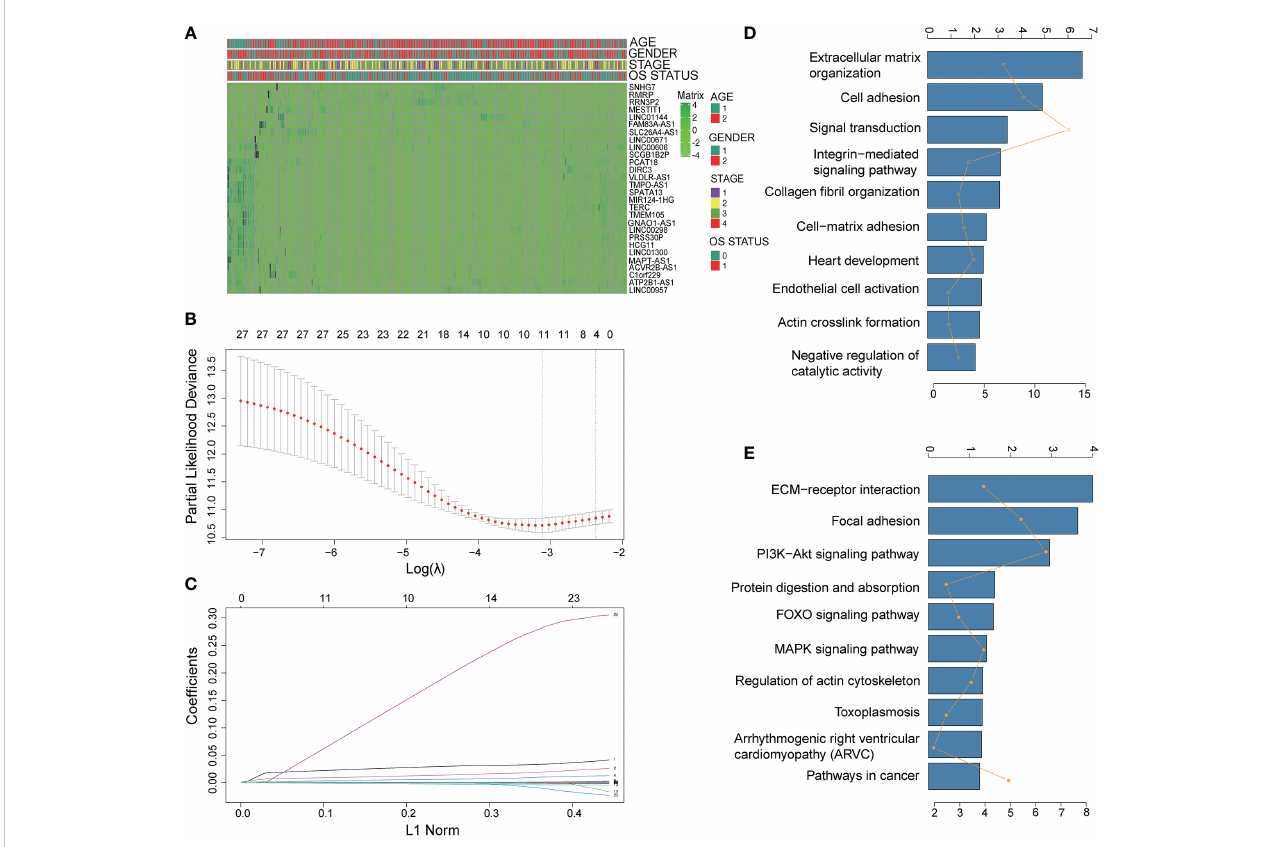
FIGURE 1 Identi fi cation of prognostic pyroptosis-related genes in gastric cancer. (A) The heatmap of 28 pyroptosis-related lncRNAs. (B) LASSO coef fi cient pro fi les of the most useful prognostic genes. (C) Cross-validation for tuning parameter selection in the LASSO model. (D, E) Gene set enrichment analysis of the lncRNA signature. (D) : GO annotation; (E) KEGG